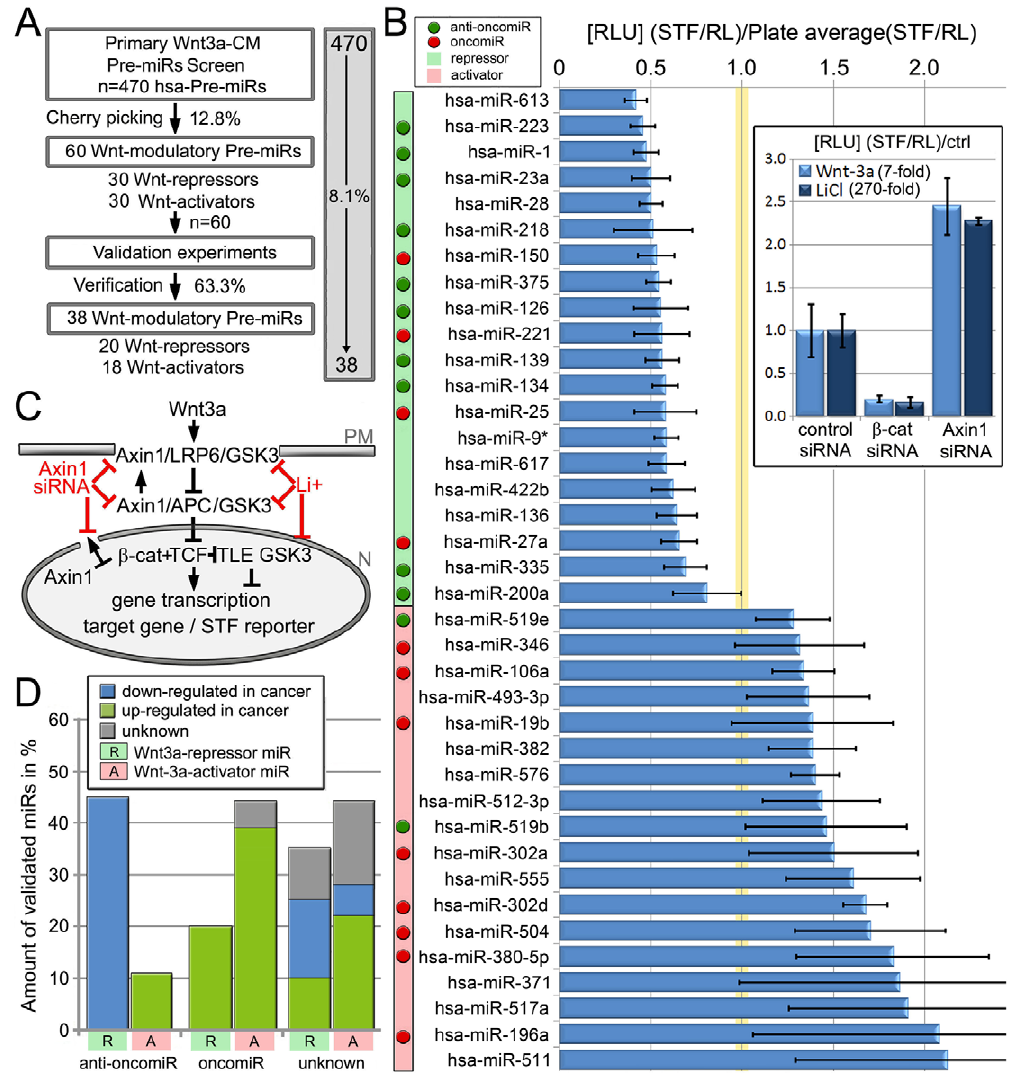
Figure 1. Validation of the Pre-miR/Wnt3a/STF-report screen in HEK293 cells. (A) Schematic overview of the screening and validation procedure. (B) Target listing of all validated synthetic cherry-pick Hsa-Pre-miRs and the average of all measurements with SEM (N=2, n=8). Color- code: Hsa-Pre-miRs that significantly repressed (green tab) or activated (red tab) the STF reporter of canonical Wnt-pathway activity. Green disc: anti- oncomiR; red disc: oncomiR. Inset: Representative performance of control siRNAs in one of the assays with LiCl or Wnt3a pathway induction. (C) Simplified sketch of important Wnt/ b -catenin pathway nodes/switches and its activation sites by axin1/2 siRNAs or LiCl (D) Correlation between Wnt- pathway repressor (R) and activator (A) miRs being anti-oncogenic (anti-oncomiRs) or oncogenic (oncomiRs). Within each column the fraction of Pre- miRs whose expression is up- or down-regulated in cancer is indicated by color.